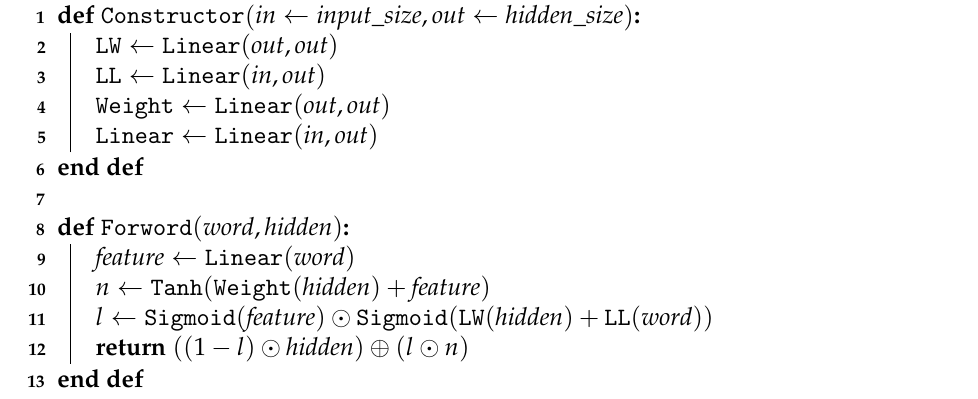
Algorithm 1: Pseudo code of CARU unit architecture, with regard to Figure 2.